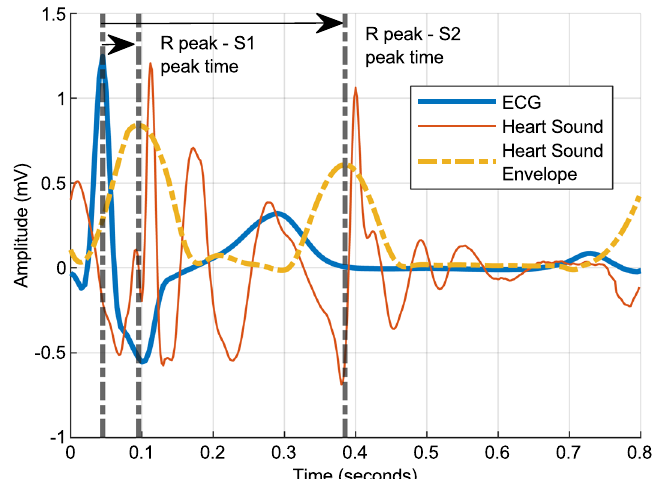
Figure 3. Cross signal features—ECG and Heart